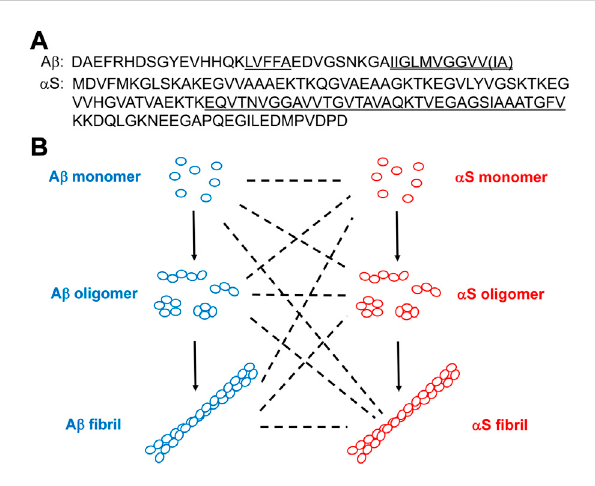
FIGURE 1 (A) Amino acid sequences of A β and α S. In A β , the hydrophobic A β 17-21 (LVFFA) and the hydrophobic A β C-terminus are shown single-underlined and double-underlined, respectively. The two additionalC-terminalresiduesofA β 42relativetoA β 40areIle-Ala shown in a parenthesis. In α S, the NAC domain is underlined. (B) Schematics of aggregations of A β and α S by self-assembly (solid lines) from their monomeric forms to oligomeric, and to fi brillar forms or via co-assembly (dotted